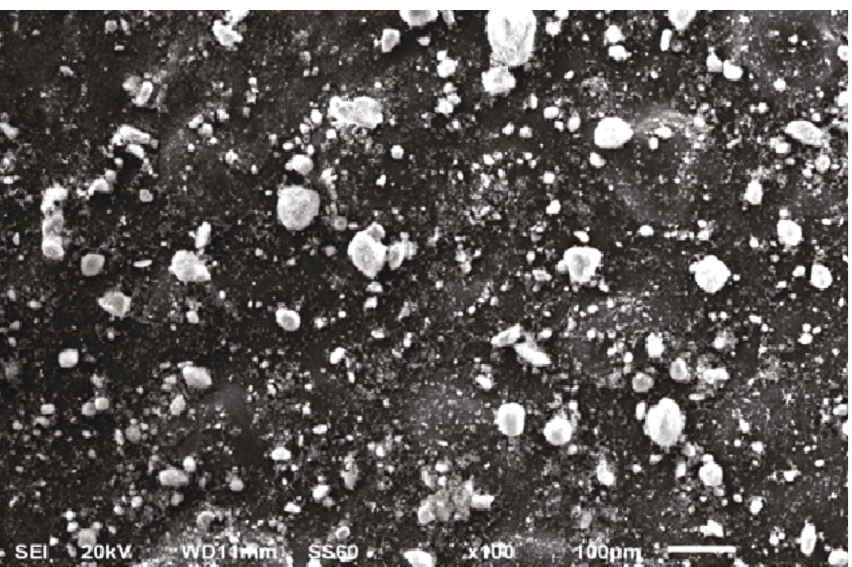
Figure 5: Scanning electron microscope image of MgO.